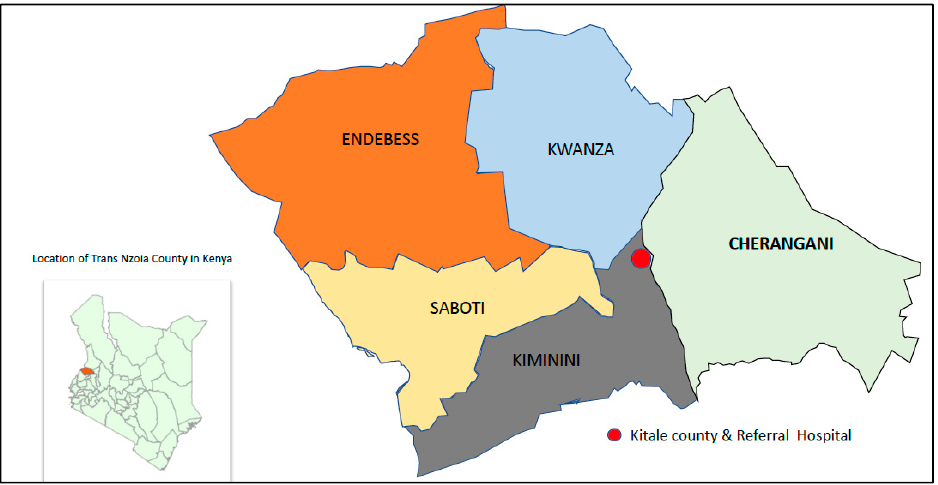
Figure 1. Location of Trans Nzoia County in Kenya and the sub-counties in relation and Kitale County & Referral hospital.